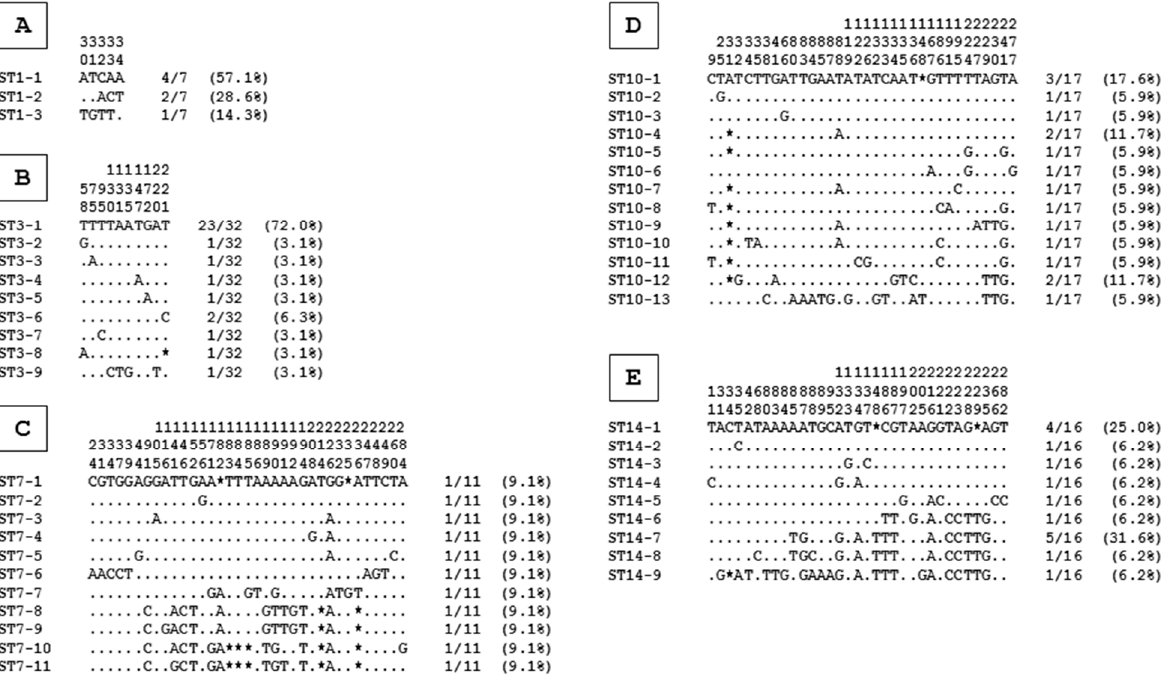
Figure 2. Alignment of partial SSU rRNA gene sequences from Blastocystis sp. ST1 ( A ), ST3 ( B ), ST7 ( C ), ST10 ( D ) and ST14 ( E ) isolates. Only the variable positions are shown in these alignments. The positions of variable positions with respect to the reference sequences (genotypes ST1-1, ST3-1, ST7-1, ST10-1 and ST14-1) are indicated above the alignment (vertical numbering). Nucleotides identical to those of the reference sequences are represented by dashes, and gaps are represented by asterisks. All the genotypes identified for each ST are indicated on the left of the alignment, whereas the total number and percentage of isolates identified in our study for each genotype are reported on the right.